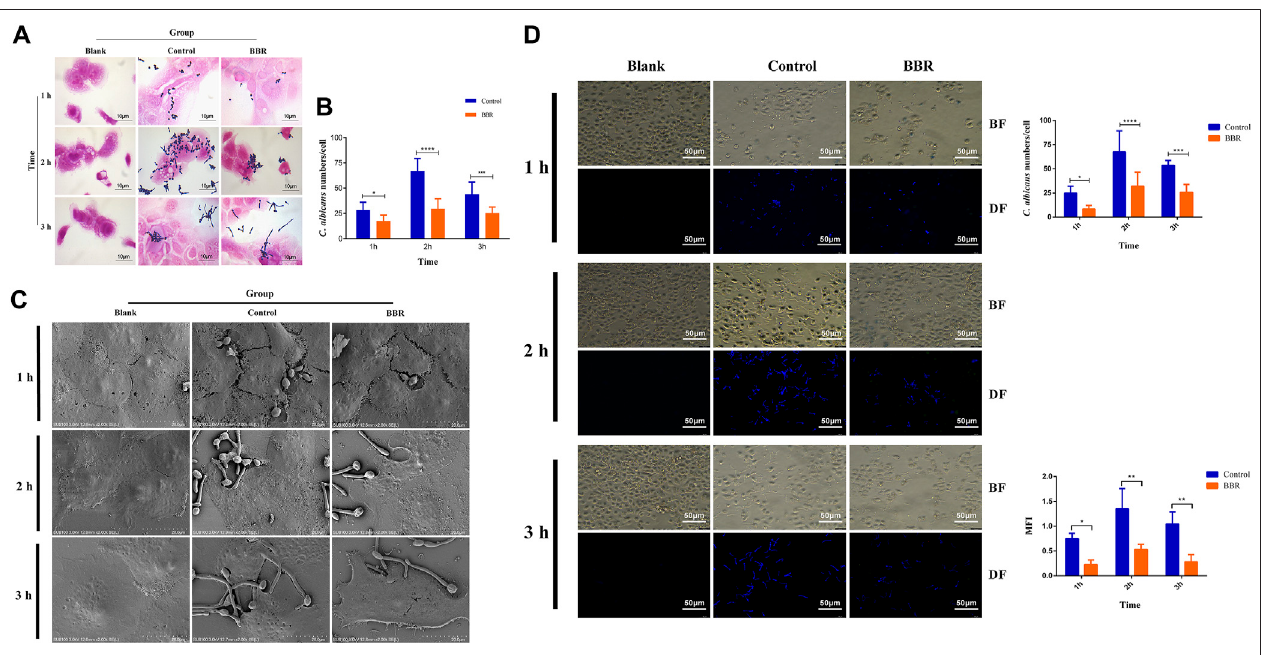
FIGURE 4 | (A) Light microscopy image, and (B) quanti fi cation (C) SEM images and (D) Fluorescent images, quanti fi cation of C. albicans numbers adhered to A431 cells and quanti fi cation of mean fl uorescence intensity of C. albicans numbers adhered to A431cells in the Blank, Control, and BBR(32 μ g/ml) groups at 1, 2, 3 h, respectively. BF: Bright fi eld, DF: Dark fi eld; * p < 0.05, ** p < 0.01, *** p < 0.001, **** p < 0.0001. vs. Control group. Scale bar, 10 μ m (A) , 20 μ m (C) and 50 μ m (D)